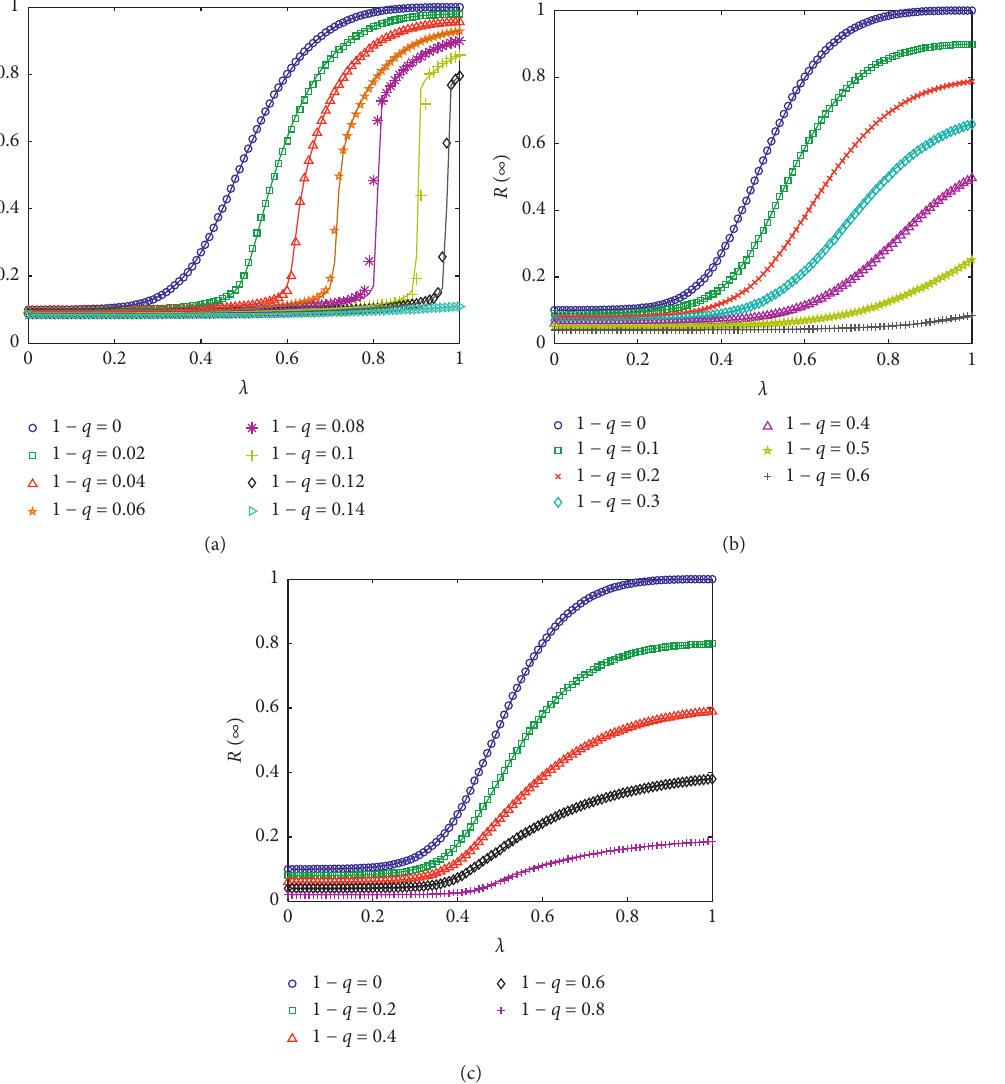
Figure 1: The final adoption size R ( ∞ ) versus the information transmission probability λ on SF network with degree exponent c (a) α � 3, (b) α � 0, and (c) α � − 3. Theoretical results (lines) agree well with simulated results